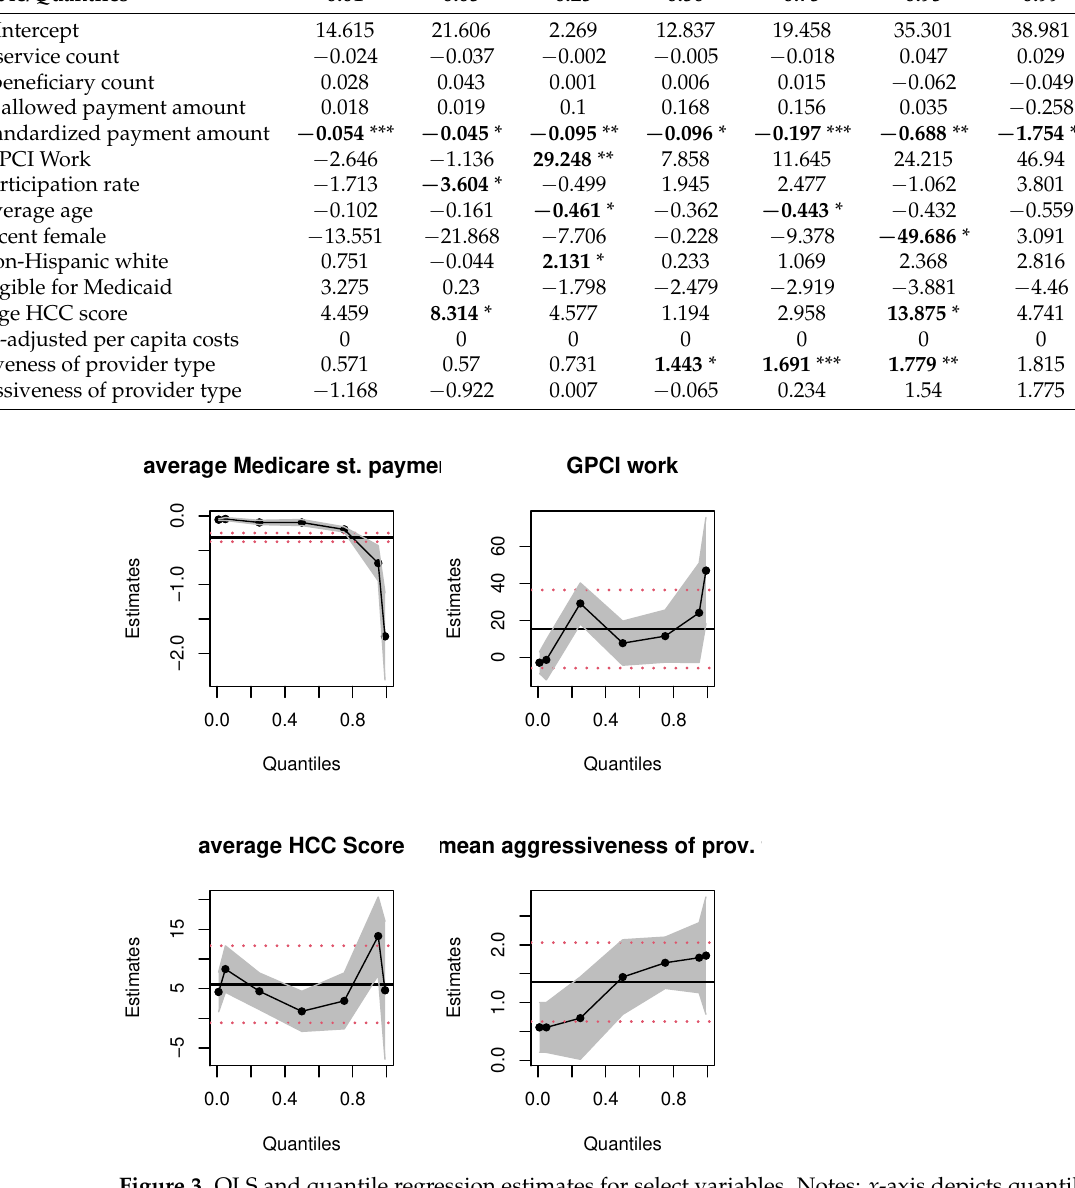
Figure 3. OLS and quantile regression estimates for select variables. Notes: x -axis depicts quantiles of the dependent variable; y -axis represents parameter estimates. The solid black line and dashed red lines are the OLS and 95% confidence interval estimates, the dotted black line and gray shaded areas are the quantile functional and 95% confidence band estimates,